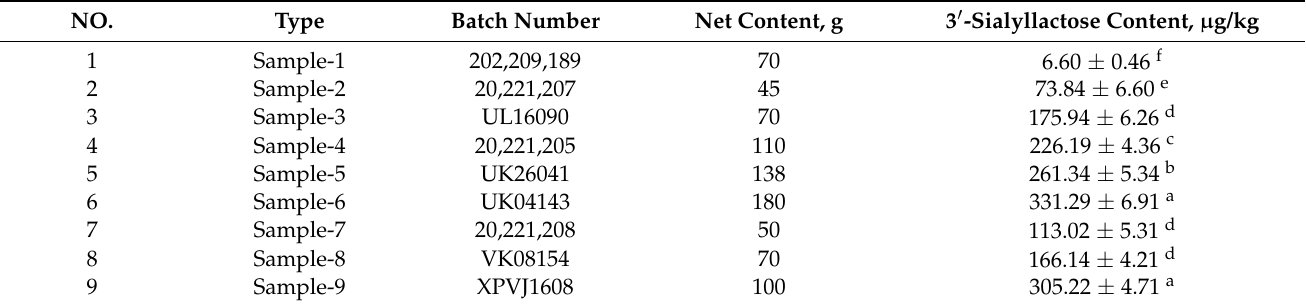
Table 4. Comparison of 3 (cid:48) -sialyllactose content in different edible bird’s nest products ( n = 2, p < 0.05).